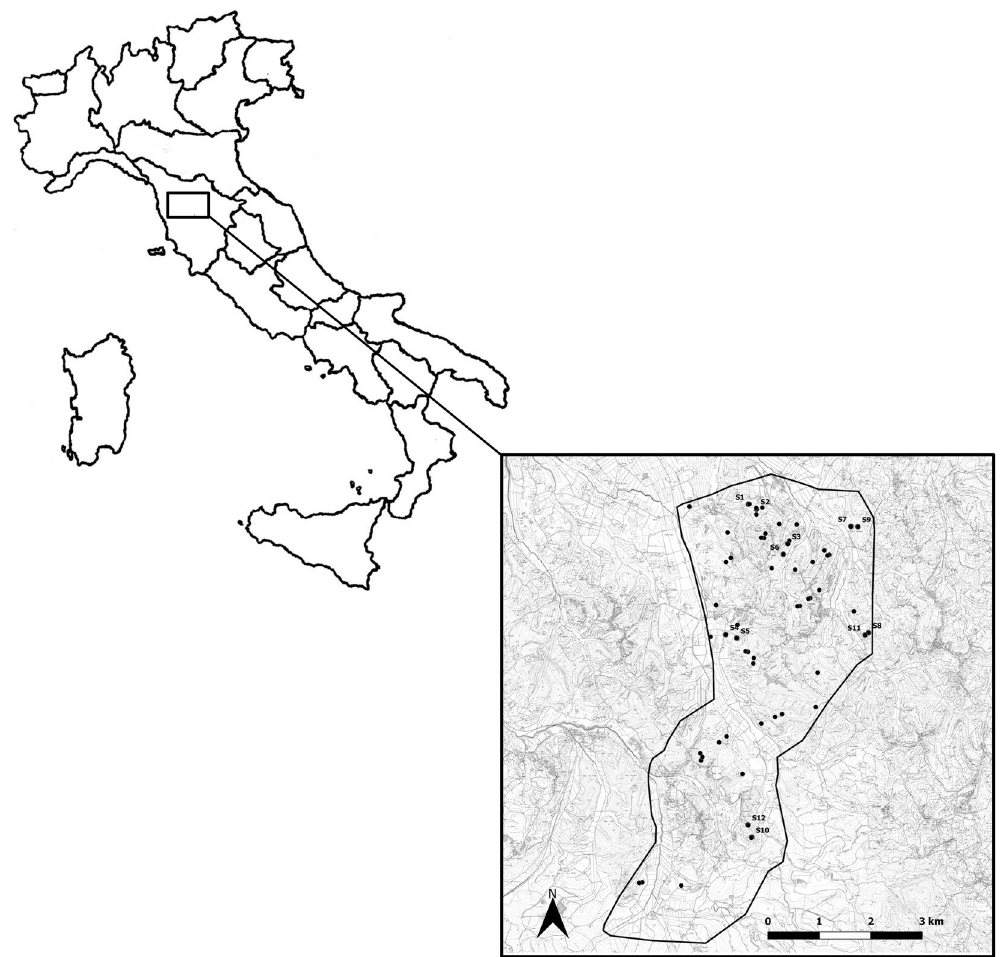
Figure 4. Map of Italy: in the inset detail of the study area (border black line), known and monitored settlements for porcupine’s inhabitation frequencies analysis (black dots) and the monitored experimental settlements (black dots, from S1 to S12) where the investigation on the spatio-temporal inhabitation were